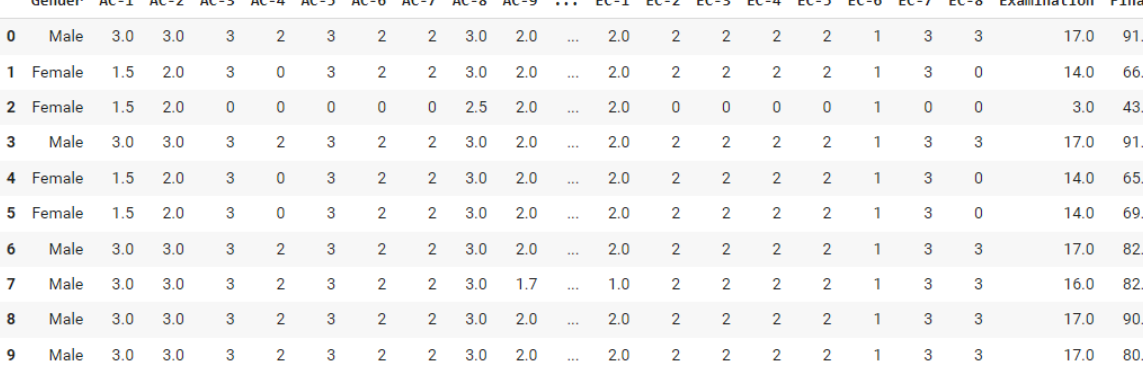
Figure 3. Dataset for ML